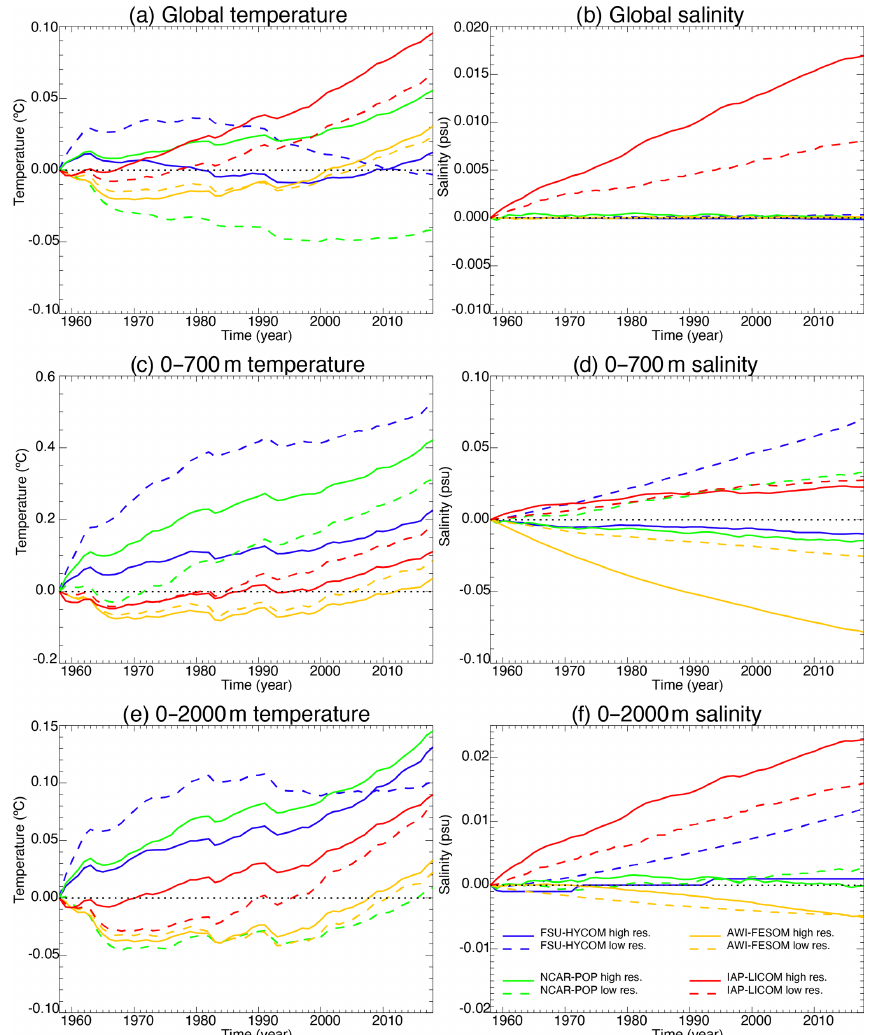
Figure 4. Time evolution of global temperature ( ◦ C) and salinity (psu) change (relative to initial conditions) for all experiments (depth- integrated, upper 700m, upper